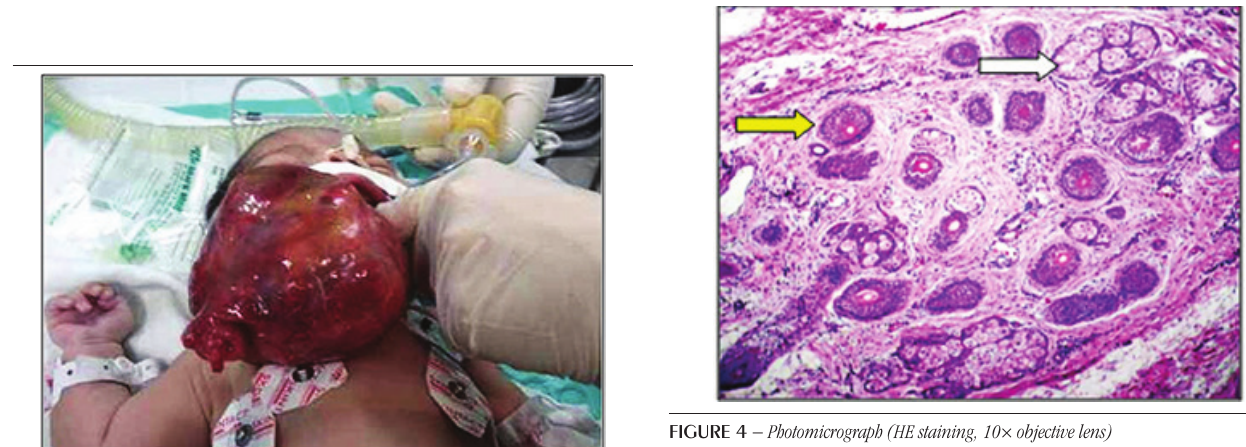
figuRE 1 − Ultrasonographic aspect Presence of an echogenic mass protruding from the oral cavity.